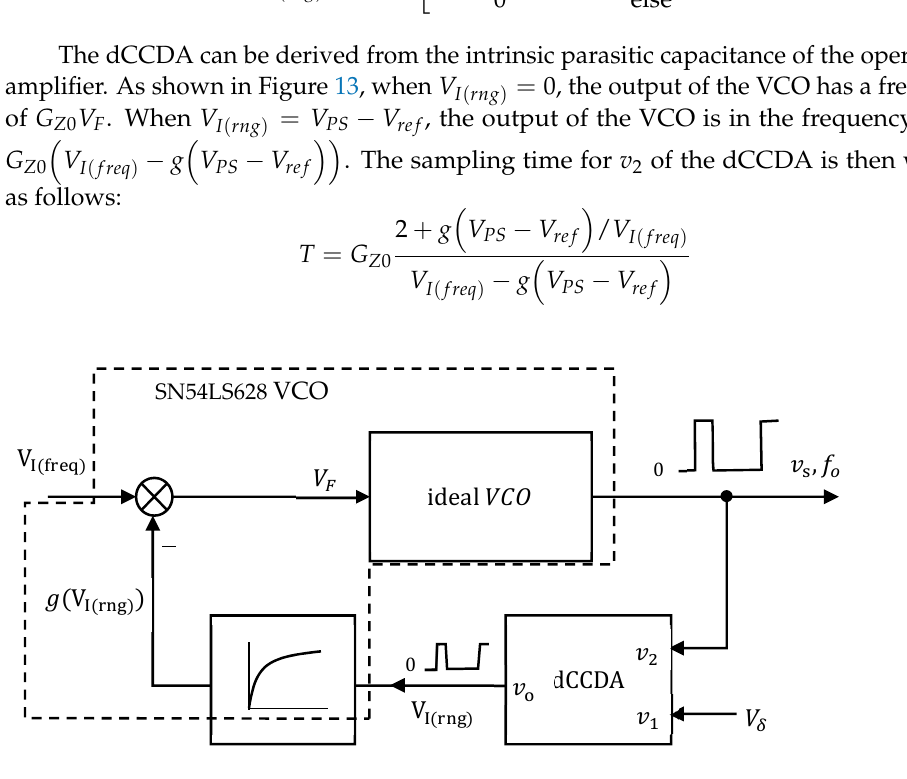
Figure 13. VFPWM with a low-resistance dCCDA feedback to a VCO.